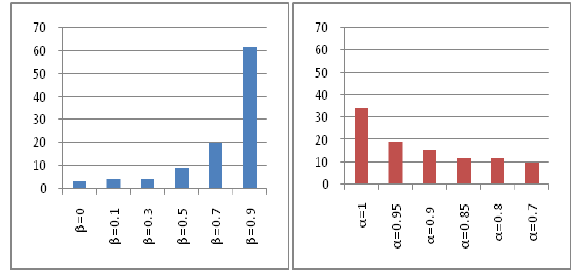
Fig. 3. The percentage of attaining the best results for different α and β values (PASSWOC)